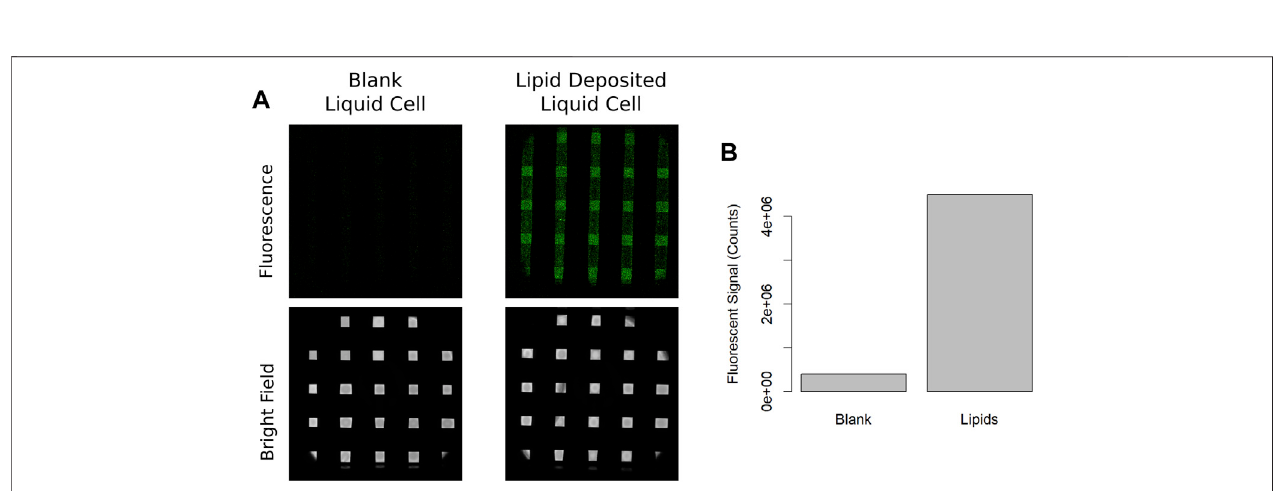
FIGURE2 |(A) Fluorescence image ofa set ofblank silicon nitride windows assembled only withdistilled water and fl uorescence imageofa liquid cell membranes wherethetopmembranehasbeencoatedwitha fl uorescentlipidbilayercontainingcarboxy fl uorescein. (B) Total fl uorescentsignalforblankandlipiddepositedimages.